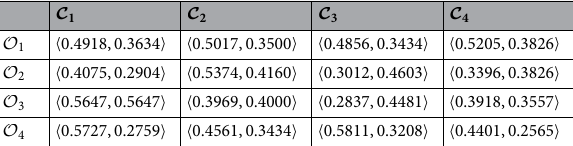
Table 9. Aggregated q-rung orthopair fuzzy decision